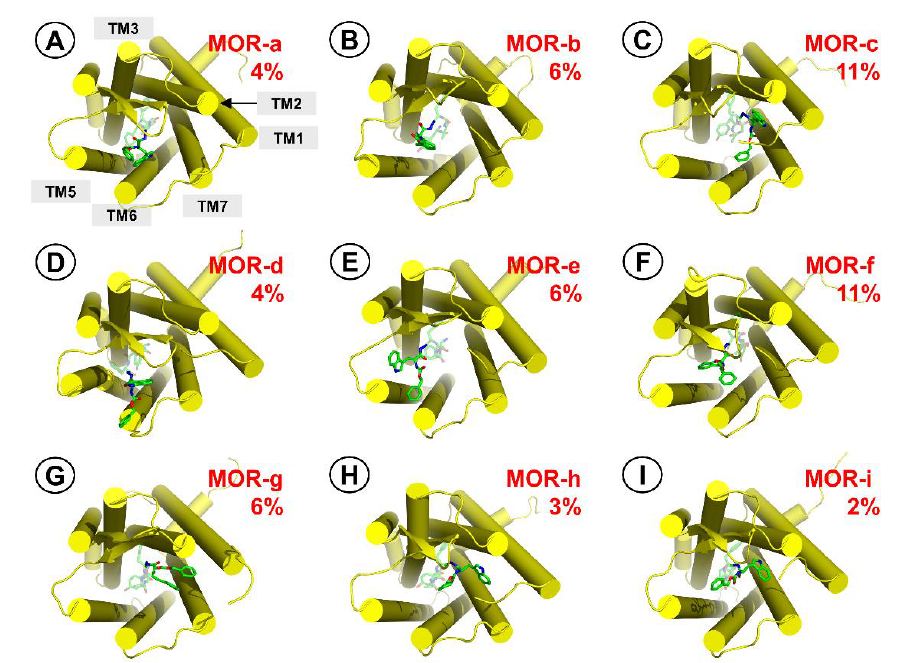
Figure 7. Representative structures for the clusters from MD simulations of AA3266 in the MOR binding site. Focus on the antitachykinin part. ( A ) MOR-a cluster, ( B ) MOR-b cluster, ( C ) MOR-c cluster, ( D ) MOR-d cluster, ( E ) MOR-e cluster, ( F ) MOR-f cluster, ( G ) MOR-g cluster, ( H ) MOR-h cluster, ( I ) MOR-i cluster. Receptor is represented as yellow cylinders (transmembrane helices, TM). The ligand is shown as green sticks. The red number is the cluster population. Table 3. Description of representative structures for clusters related to -NH-NH<-Z- D -Trp part.